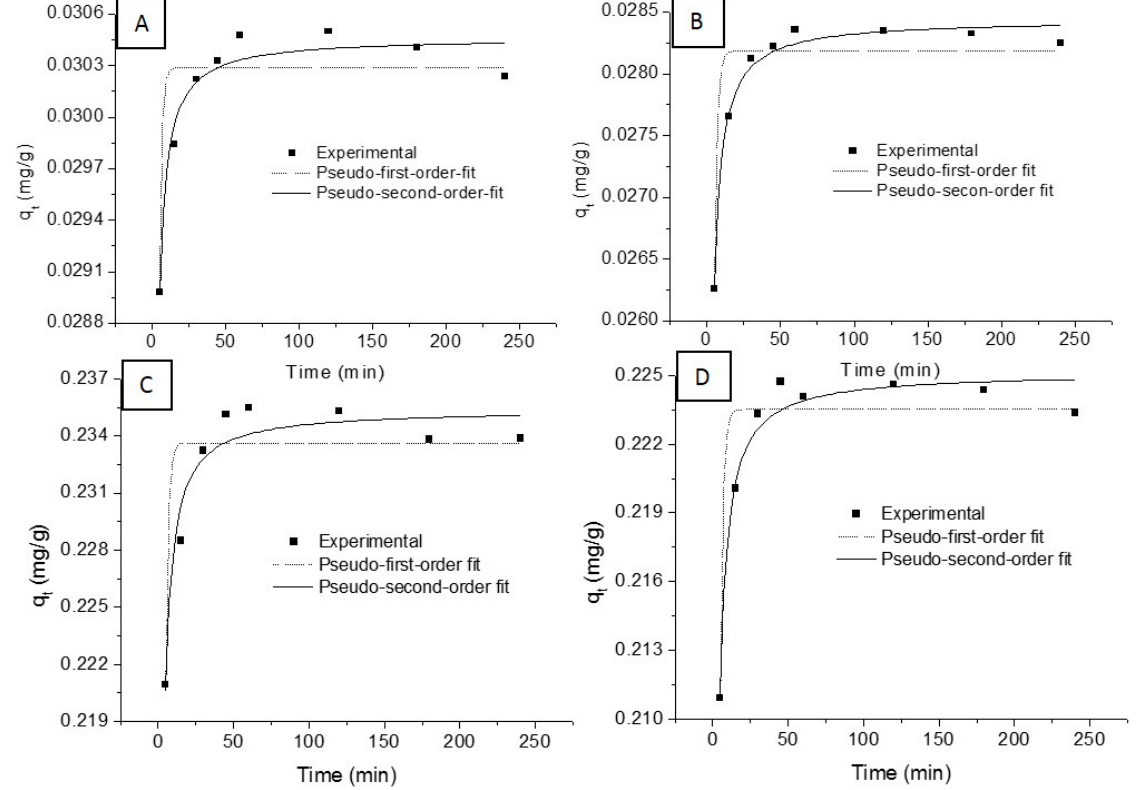
Figure 5. Pseudo-first-order and pseudo-second-order kinetic model fits and experimental kinetic data: ( A ) Ch–Rs (0.25 mg/L As(V)), ( B ) Ch–Pu (0.25 mg/L As(V)), ( C ) Ch–Rs (2.0 mg/L As(V)), and ( D ) Ch–Pu (2.0 mg/L As(V)) (initial pH 7, 8 g/L adsorbent, shaking at 200 rpm at 24 ± 1 °C).